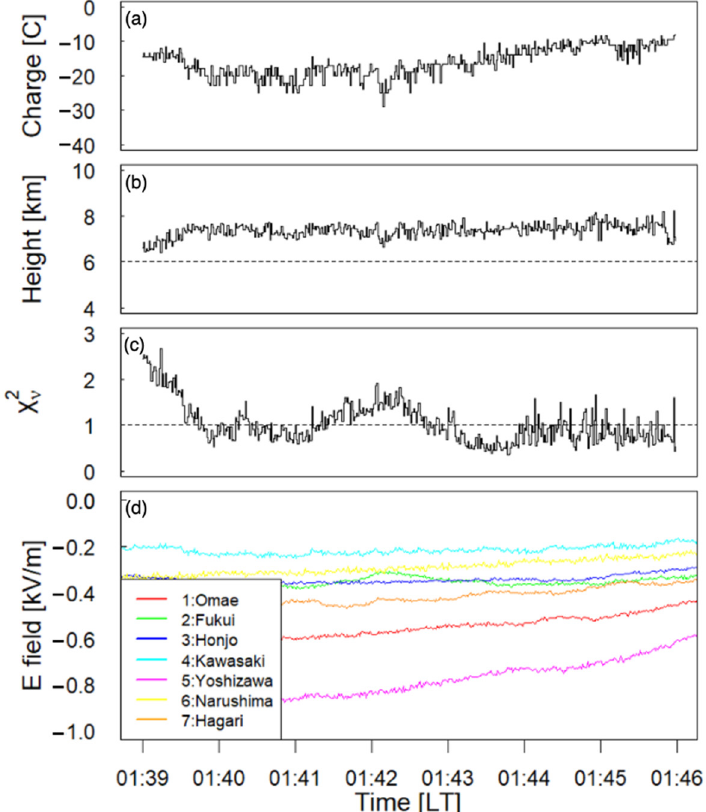
Figure 11. Panel ( a ) and ( b ): Temporal variations of the quantity Q (C) and height H (km), respectively, of the point charge model during the period 1:39–1:46 (LT) on 27 August 2020. ( c ) Value of χ ν 2 during the same period of other panels. ( d ) Electrostatic waveforms obtained by our EFM network.